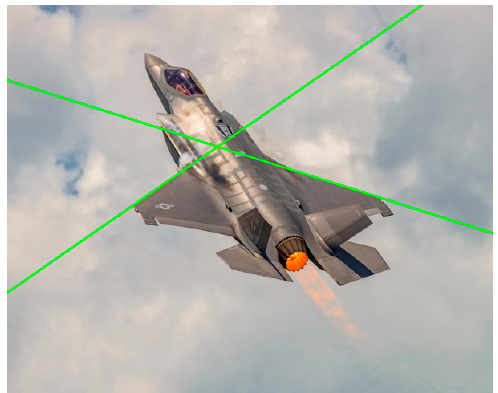
Figure 6. The result of wing leading edge extraction.